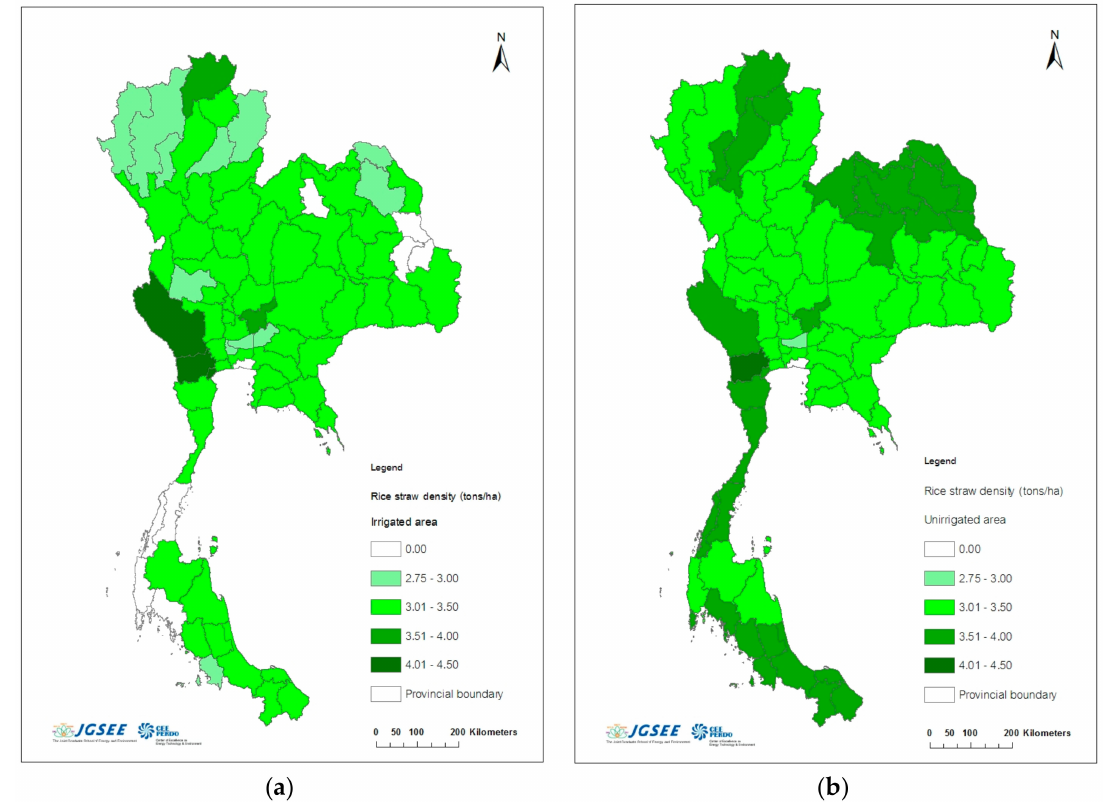
Figure 5. Rice straw density in each province classified by water resource system: ( a ) irrigated area; ( b ) rain-fed